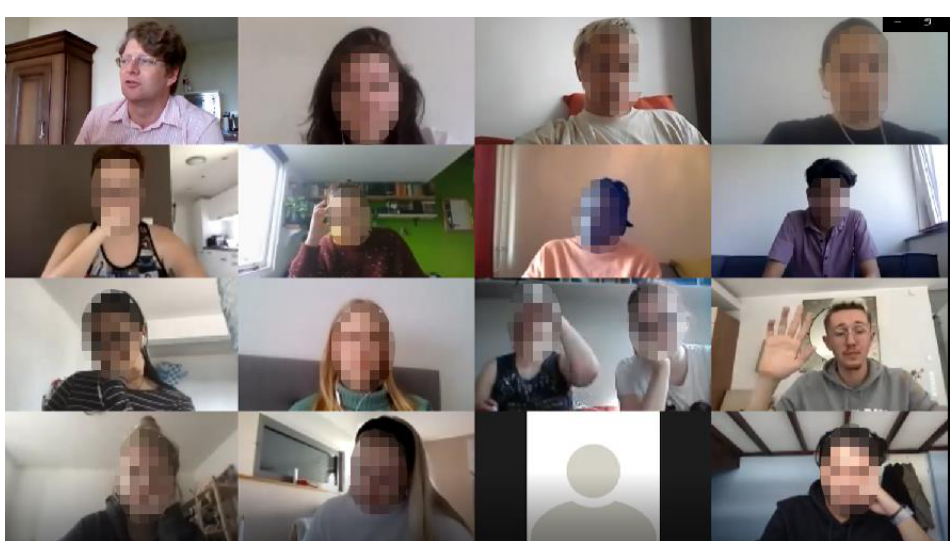
Figure 3. Visual representation of participant behaviors 3.